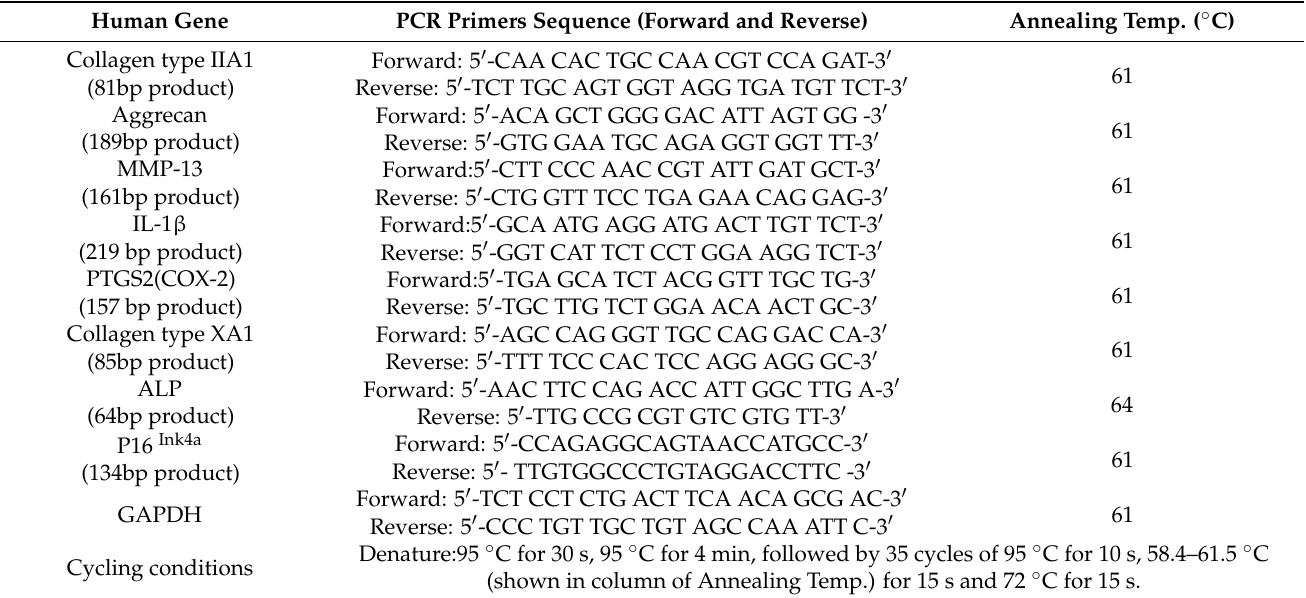
Table 1. Primer sequences and cycling conditions for real-time